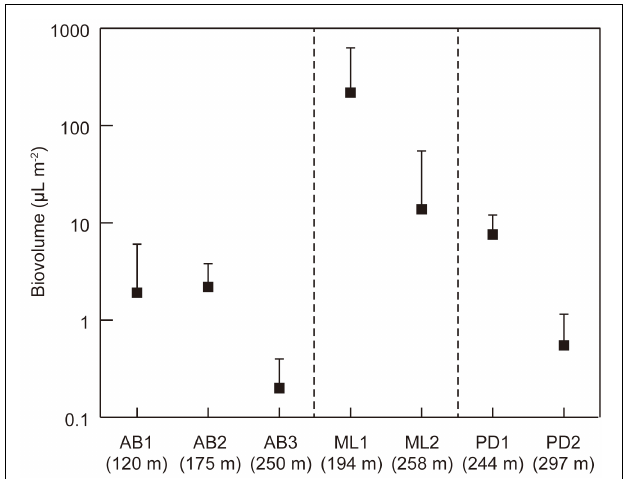
FIGURE 5 | Variations in total cell volume biomass (biovolume) of phototrophs at the study sites on the three glaciers in Svalbard. AB1-3, Austre Brøggerbreen; ML1-2, Midtre Lovénbreen; PD1-2, Pedersenbreen. Error bar = standard deviation.